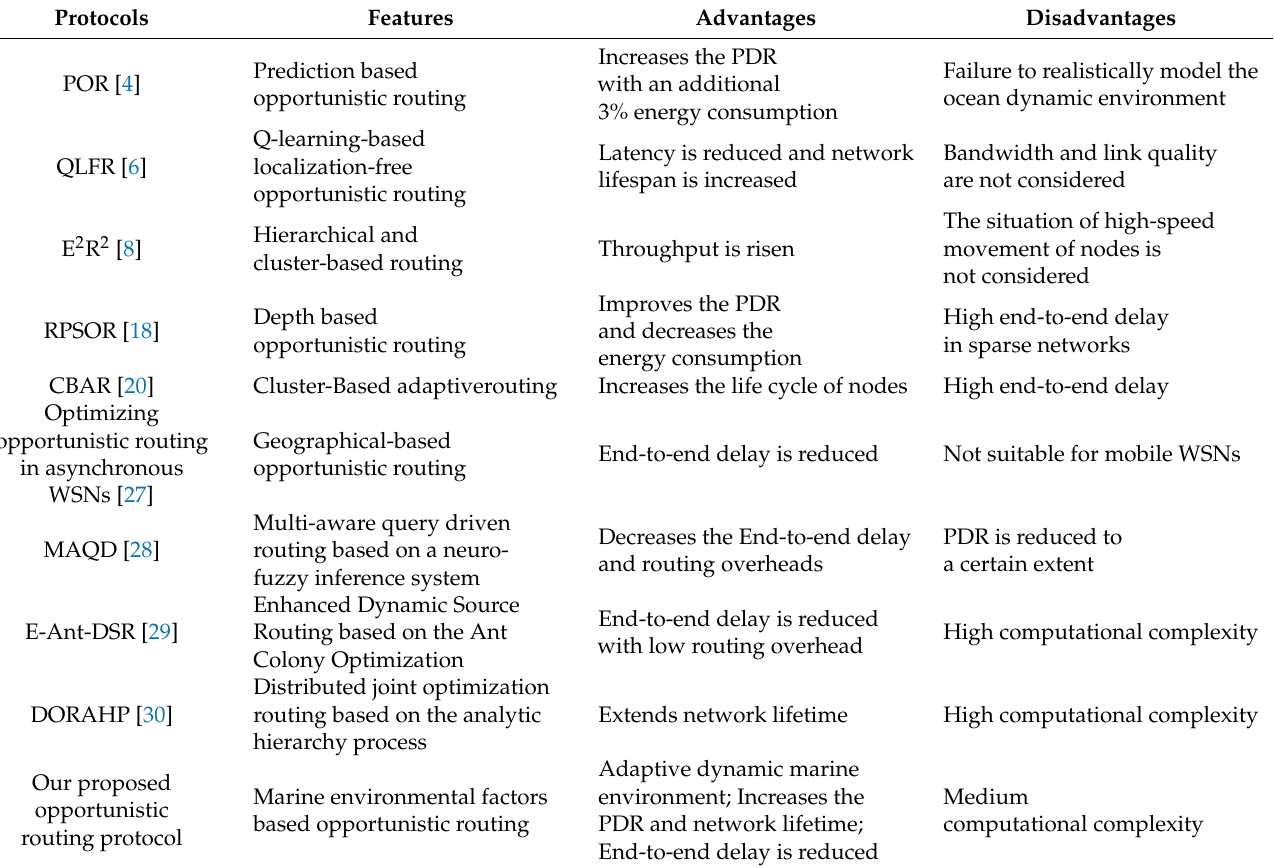
Table 1. The comparison of the proposed opportunistic routing protocol and benchmark routing